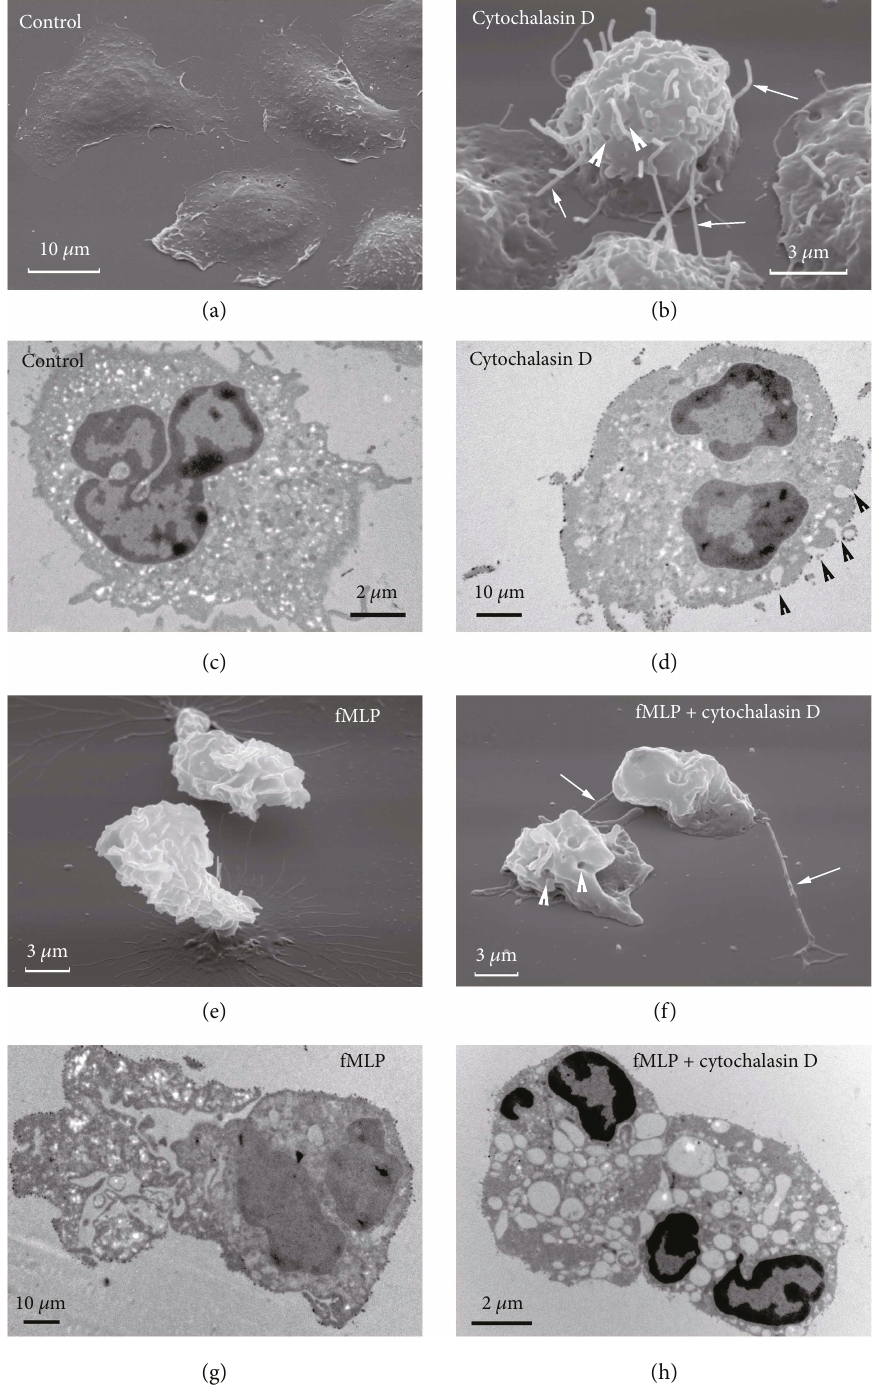
Figure 1: E ff ect of cytochalasin D on the external and internal morphology of control (resting) and fMLP-treated neutrophils upon adhesion to fi bronectin. SEM (a, b, e, f) and TEM (c, d, g, h) images of neutrophils that were attached to fi bronectin-coated substrata over a period of 20min under the control conditions (a, c), in the presence of 10 μ M cytochalasin D (b, d) or in the presence of 1 μ M fMLP, taken separately (e, g) or together with 10 μ M cytochalasin D (f, h). The white arrows point to the cytonemes. Arrowheads (white for SEM and black for TEM images) indicate invaginations of the plasma membrane. Pictures represent typical images observed in two independent